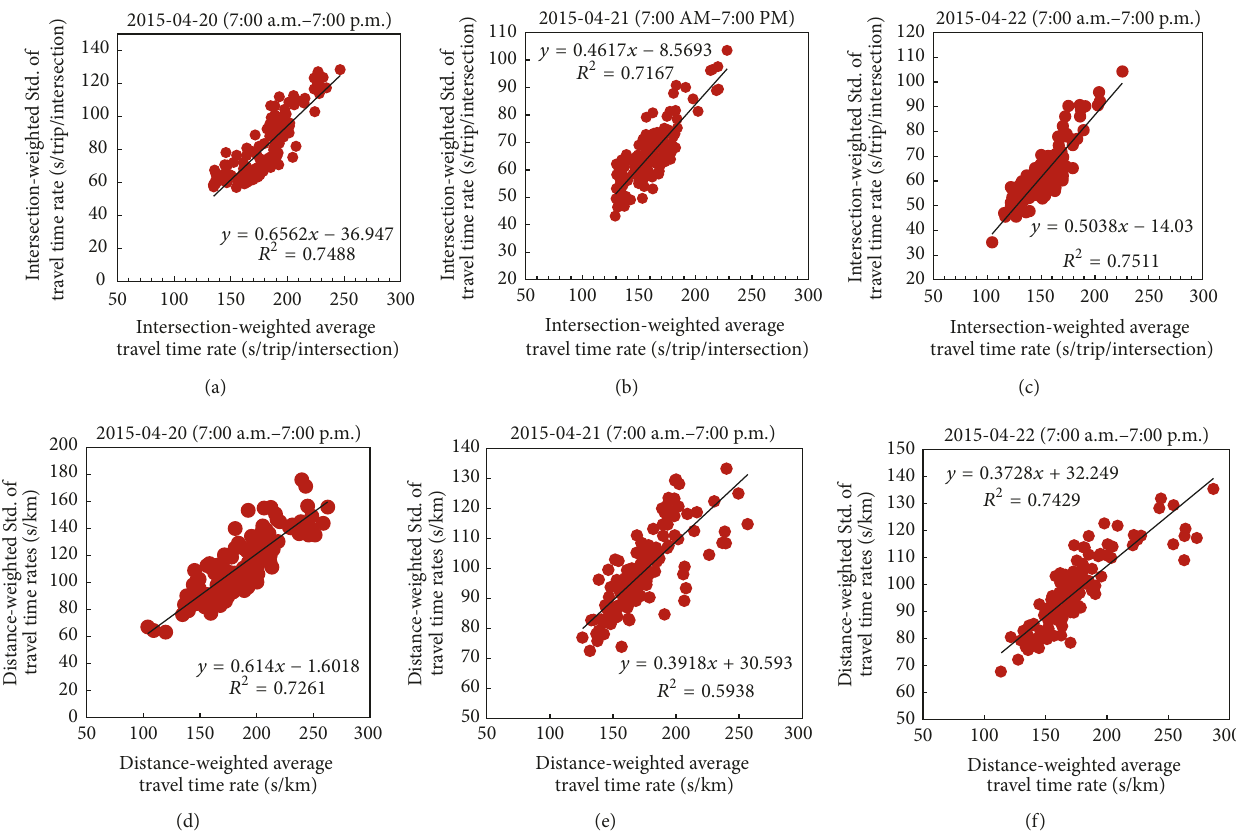
Figure 6: Weighted average travel time rate versus weighted standard deviation of travel time